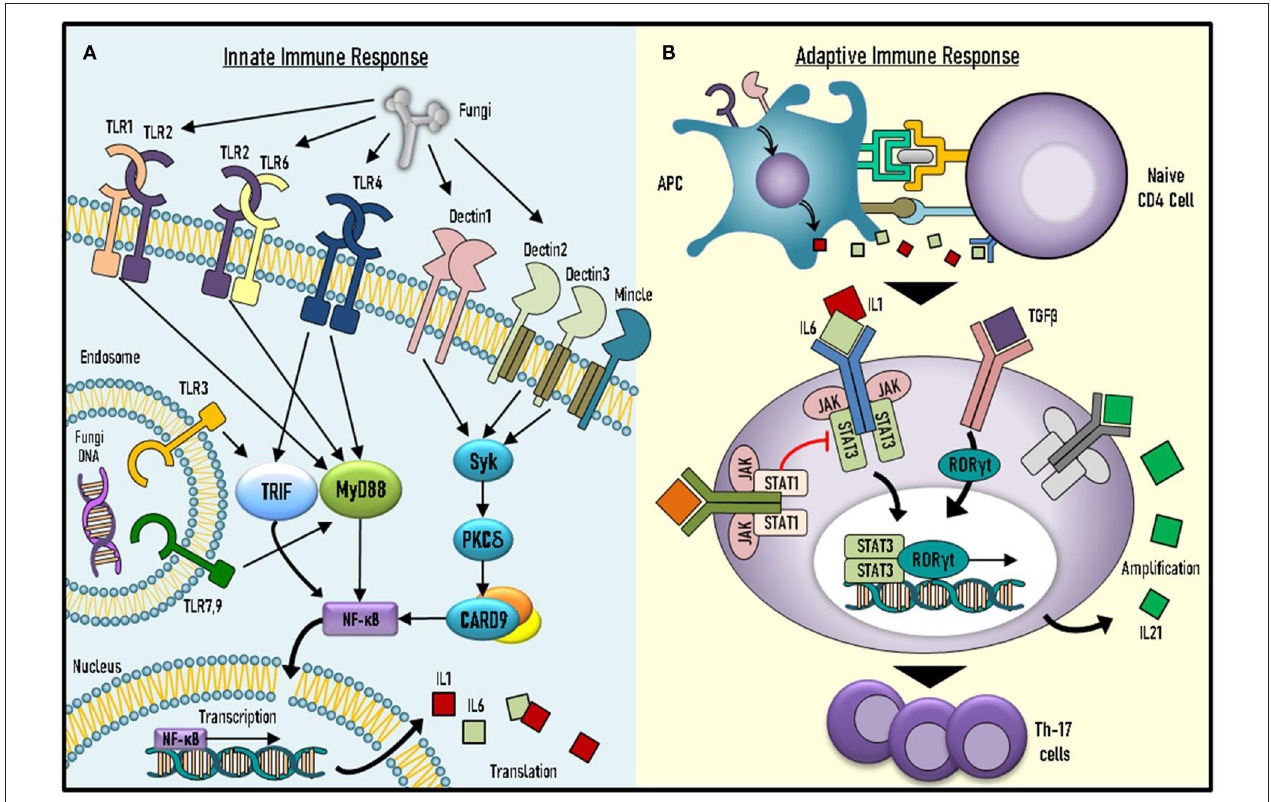
FIGURE 1 | Underlying mechanisms of immune responses against Candida spp . (A) Candida spp. recognition and initial immune response involve key molecules of the innate system. (B) Adaptive response against Candida spp. includes activation and differentiation of naïve CD4 + T cells into effector T helper 17 (Th17) cells. TLR, toll-like receptor; PKC- δ , Protein kinase C- δ ; MYD-88, Myeloid differentiation primary response 88; NF κ B, Nuclear factor kappa-light-chain-enhancer of activated B cells; IL-Interleukin; APC, Antigen presenting cell; TGF- β , Transforming growth factor beta (TGF- β ); JAK-Janus Kinase; STAT, Signal transducer and activator of transcription; ROR γ T, RAR-related orphan receptor